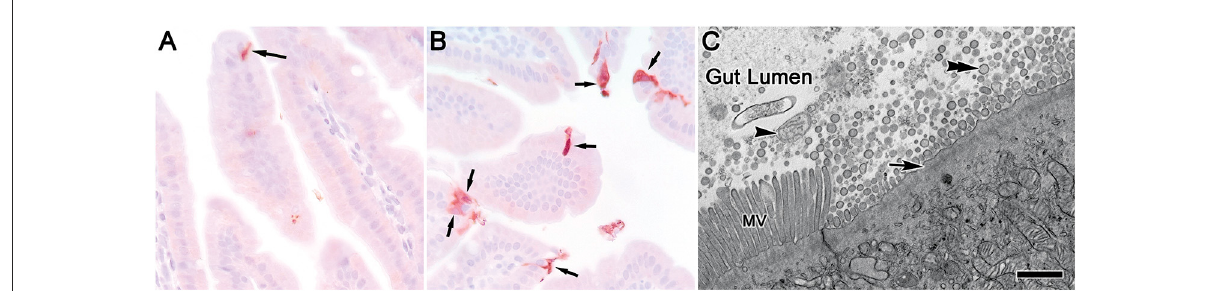
FIGURE1 Mouse small intestine enterocytes after exposure to 200nm PSNS. Enterocytes immunolabeled for cleaved caspase-3 [arrows in (A,B) ] 1.5h after gavage with (A) vehicle control and (B) 200nm PSNS. Nova red as chromagen and hematoxylin as counter stain. (C) Enterocytes from mouse small intestine (jejunum) 25.5h after gavage with 200nm PSNS, fixed and stained by the conventional method, and imaged by transmission electron microscopy. An enterocyte is showing signs of lytic cell death (arrow) with blebs of putative apoptotic bodies (double arrowhead) and mitochondria (arrowhead) in the gut lumen. Note the microvilli (MV) of an adjacent enterocyte. Scale = 30 µ m in (A,B) ; 1 µ m in (C) .